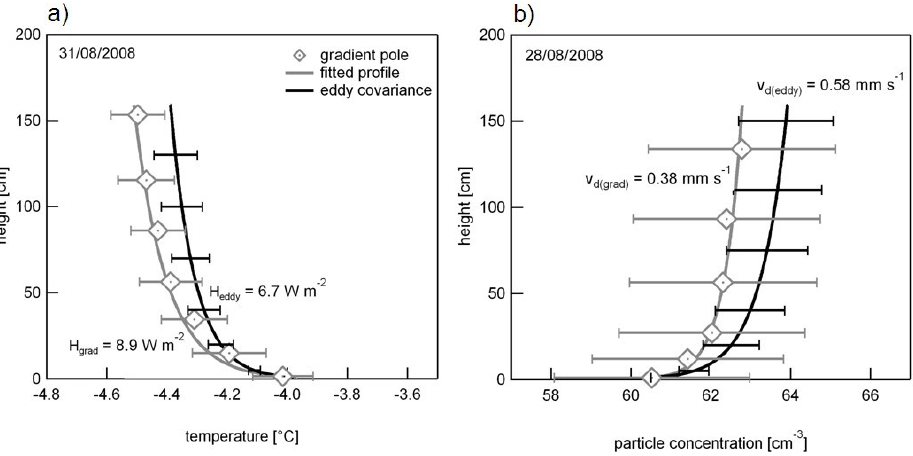
Fig. 8. Intercomparison of profiles fitted to the gradient pole data (grey) and profiles consistent with the simultaneous eddy covariance flux measurement (black). (a) Temperature profiles on 31 August, and (b) particle concentration profiles on 28